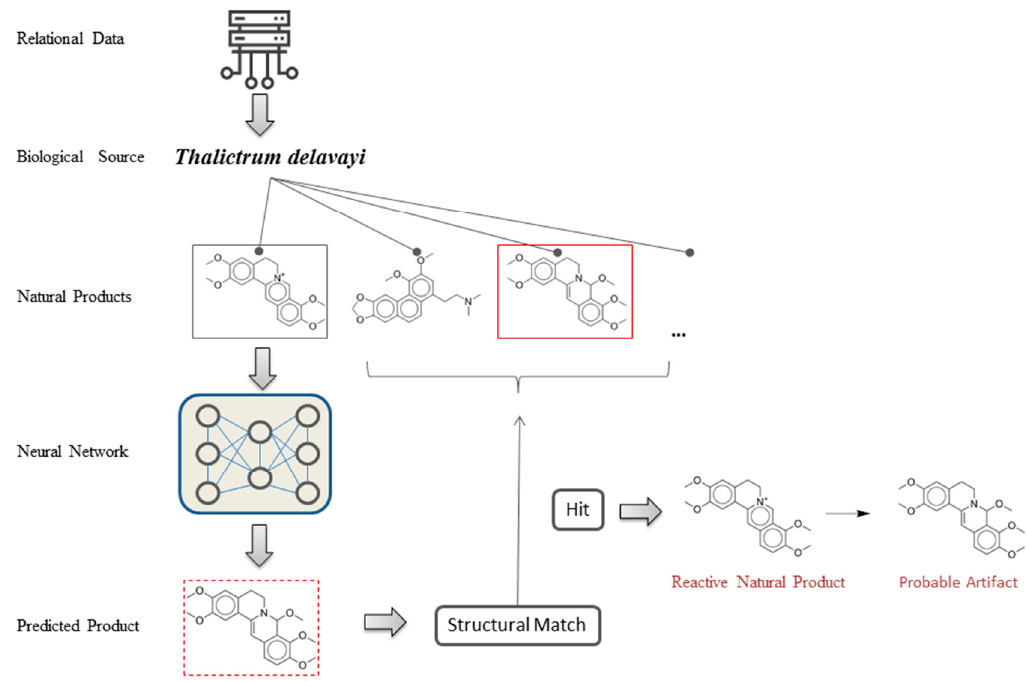
Figure 1. Illustration of the virtual screening system for discovering reactive natural products and their probable artifacts [17,18]. Table 1. Example of a set of relational data: natural products from Thalictrum delavayi. No.